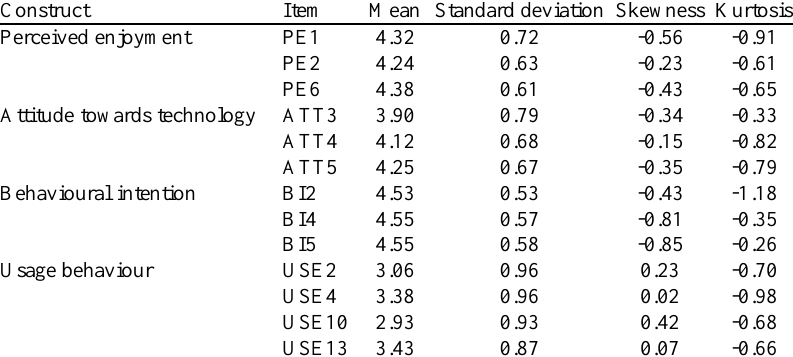
Table 1 Assumptions of skewness and kurtosis for normality of study data Construct